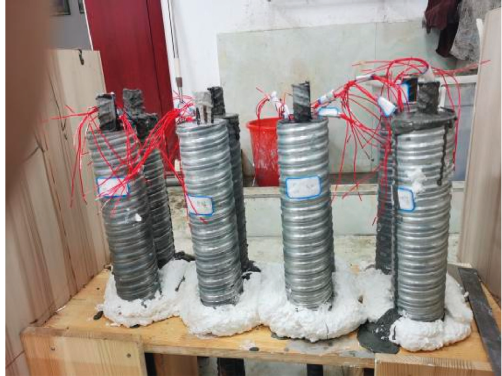
Figure 3: Specimen-forming diagram.